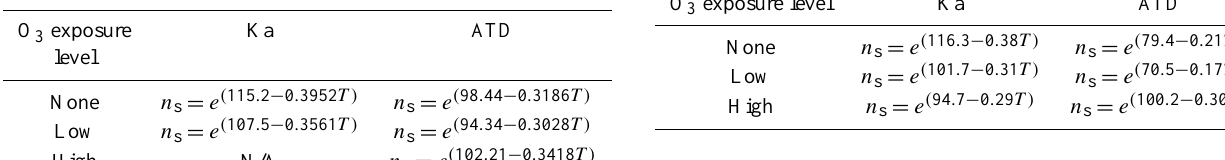
Table 5. Fits for deposition mode ice-active surface site density (m − 2 ) as a function of temperature (K) at RH w = 95% as shown in Fig. 9. O 3 exposure Ka ATD